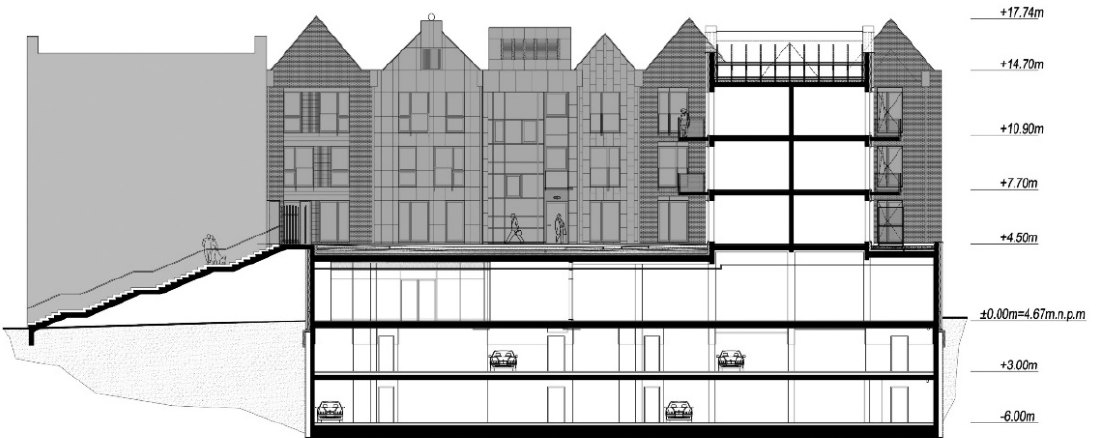
Figure 14. Cross-section through the quarter of buildings on Szeroka Street in Gda´nsk; designed by A. Taraszkiewicz. Source: A. Taraszkiewicz.